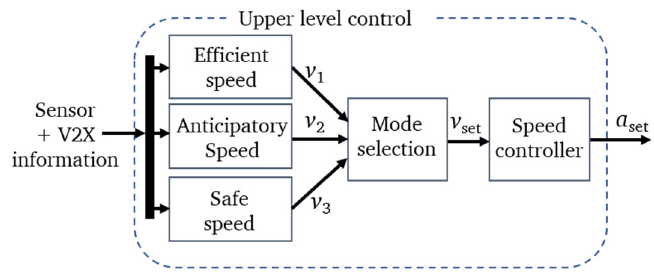
Figure 6. Framework of the upper level longitudinal control.